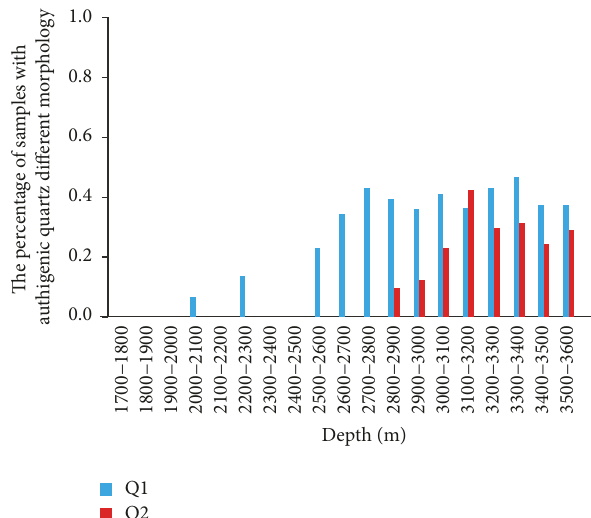
Figure 11: The distribution of authigenic quartz with different mor- phological features in sandstone of Es in Dongying Sag.